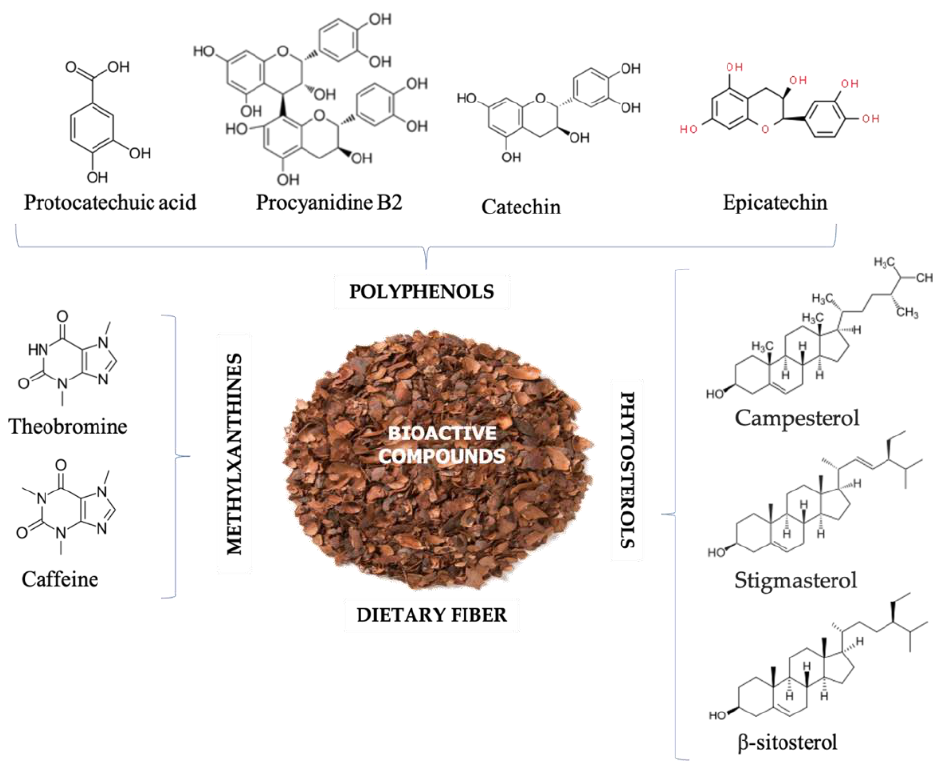
Figure 1. Major bioactive compounds extracted from cocoa bean husk and cocoa shell.